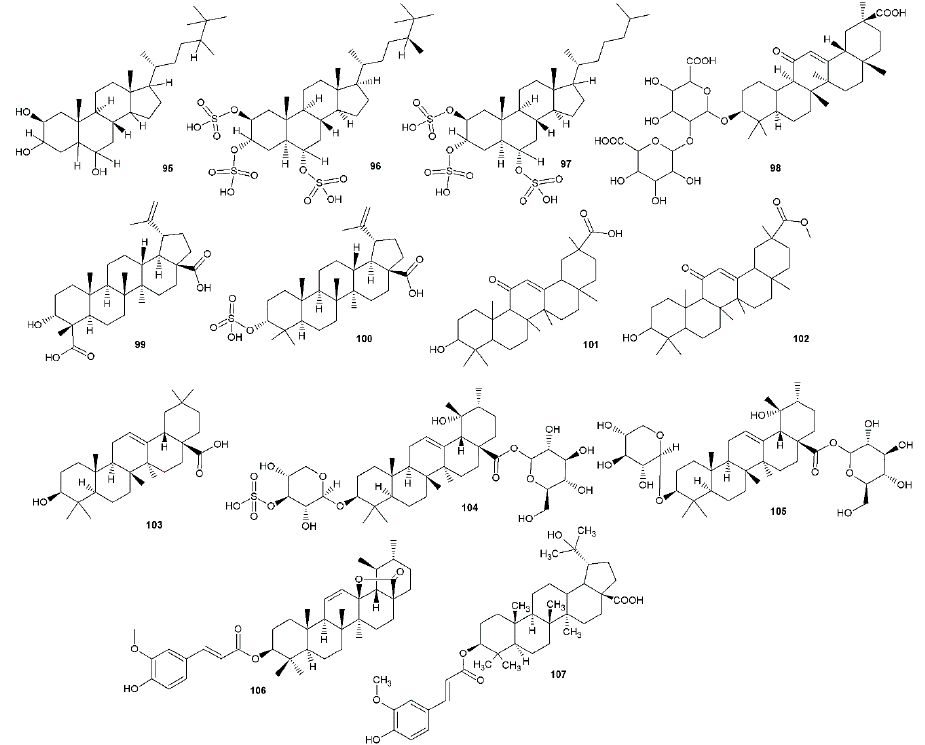
Figure 4. Terpenoid compounds with antiherpetic activity.